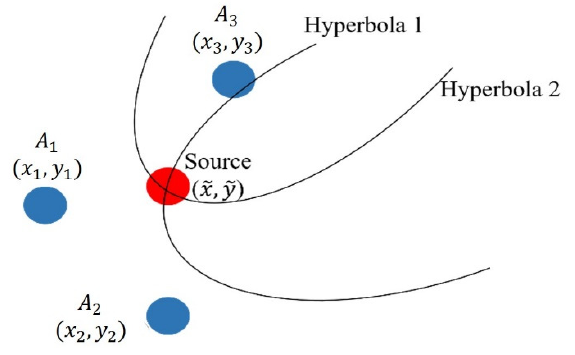
Figure 3. TDOA schematic.